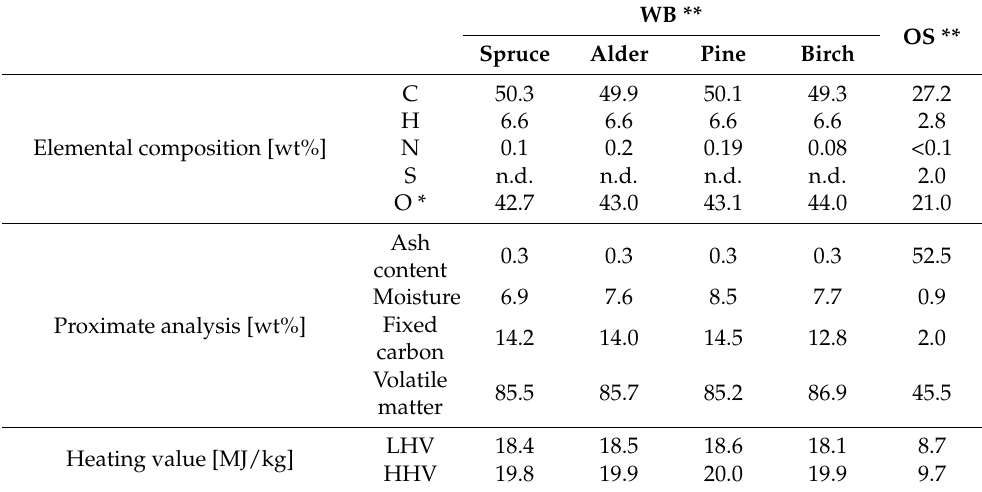
Table 1. WB and OS feedstock